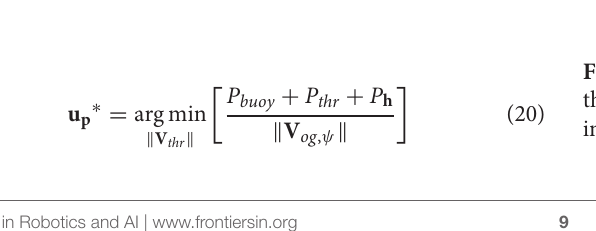
FIGURE 4 | Energy optimal propulsive speed as a function of hotel load and ocean current conditions for the 1D case. (A) Shows optimal speed as a function of hotel load alone. (B) Shows the optimal speed as a function of ocean current velocity for a range of possible hotel scenarios. Color in both subplots indicates hotel load, where hotel load values vary between transit mode ( 0.37 W ) and survey mode ( 6.37 W